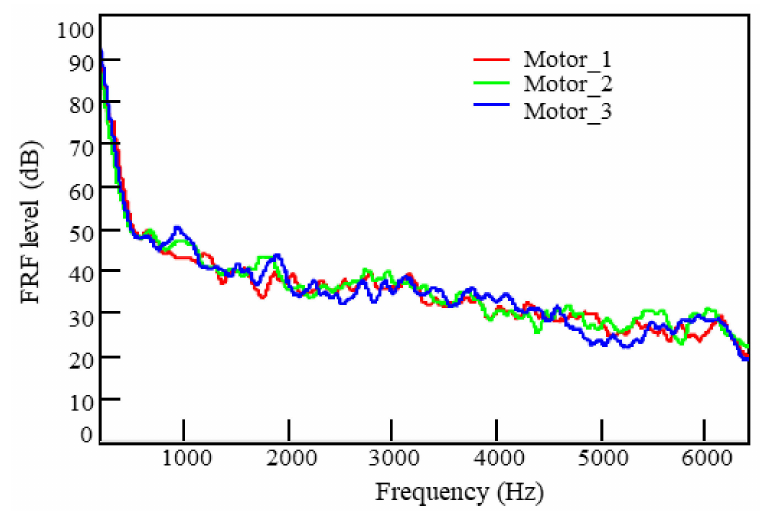
Figure 6. Measured spectra of the noise transfer functions of the